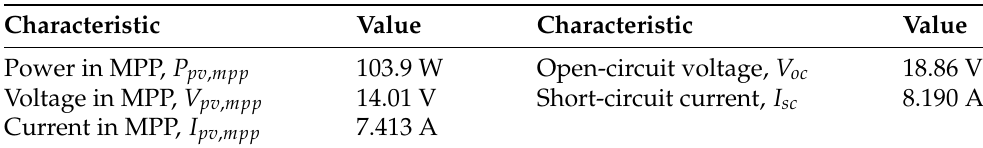
Table 3. Specifications of the LUXEN LNSA-160P PV module.